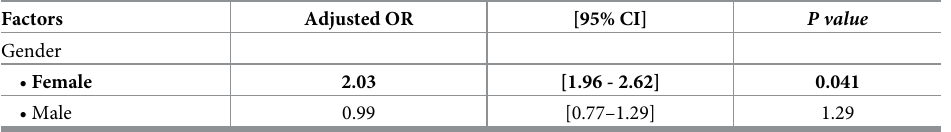
OR odds ratio, CI confidence